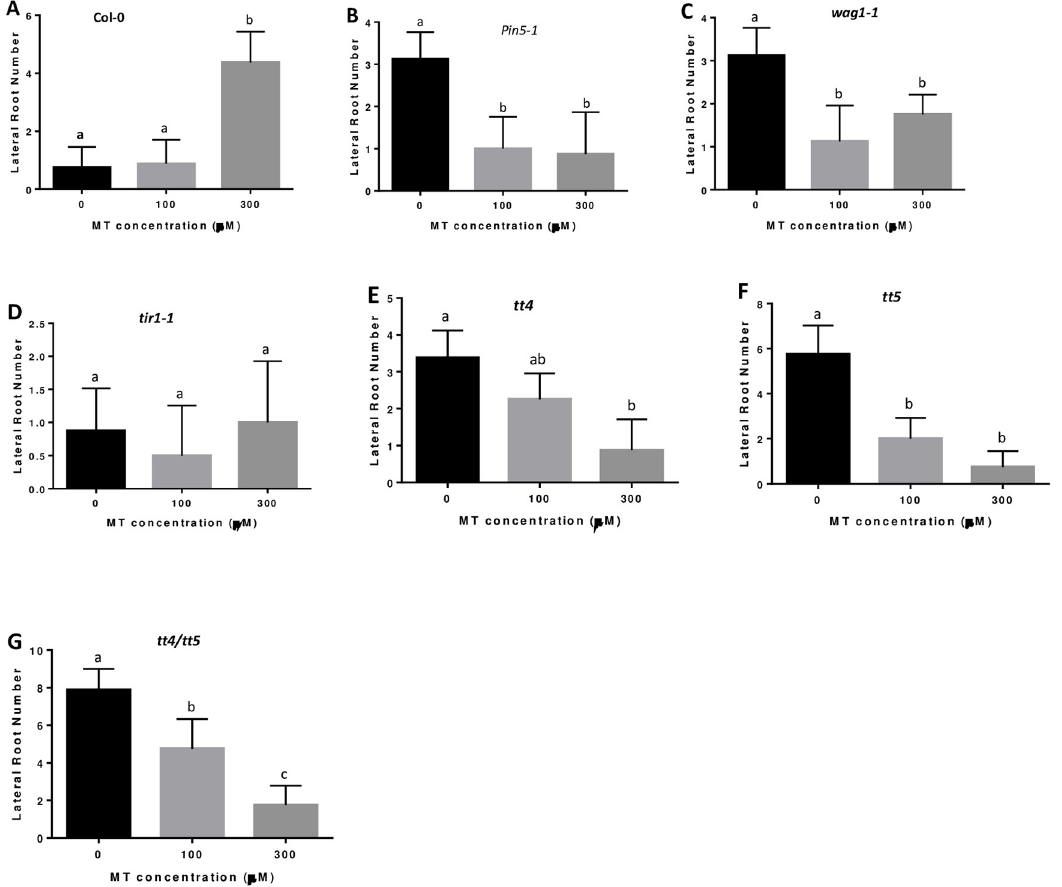
Fig 4. Auxin transport related mutants respond differently to melatonin on lateral root development. Lateral root number of Arabidopsis seedlings from wild type Col-0 (A), pin5-1 (B), tir1-1 (C), wag1-1 (D), tt4 (E), tt5 (F) and tt4/tt5 double mutant (G), growing on medium with control, 100 μ M and 300 μ M melatonin. Three independent experiments with more than 15 seedlings per measure were conducted for statistical analysis. Values represent Mean ± SD. Different letters indicate significant differences according to Duncan’s multiple range test (P < 0.05).